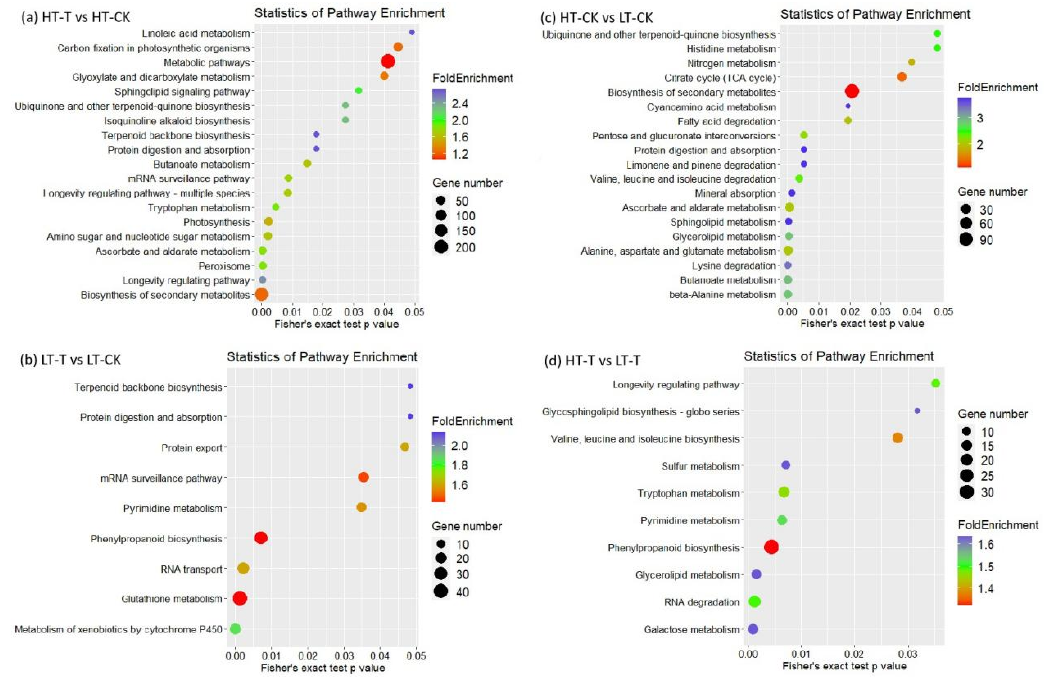
Figure 5. KEGG pathway analysis on differentially abundant proteins from each comparison. Colors indicate the degree of enrichment. Blue represents stronger enrichment, green represents strong enrichment, and red represents moderate enrichment. The p -value according to Fisher’s exact test indicates the significance level of the difference.